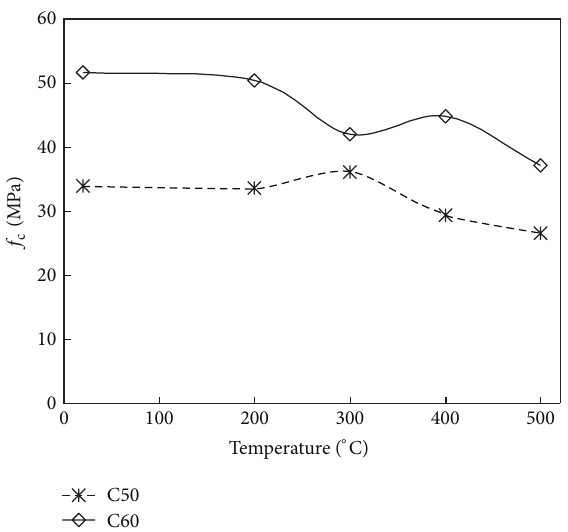
Figure 7: Cleavage strength of HPC at elevated temperature.